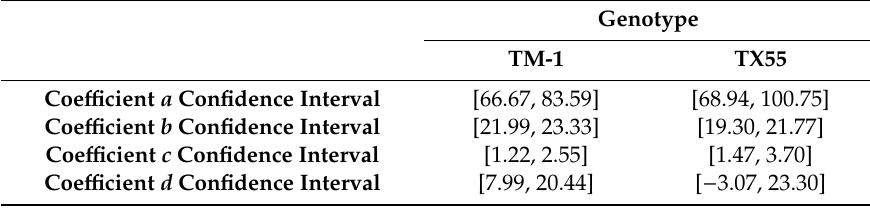
Table 1. Confidence intervals for cellulose content data. The intervals are calculated at 95% confidence.